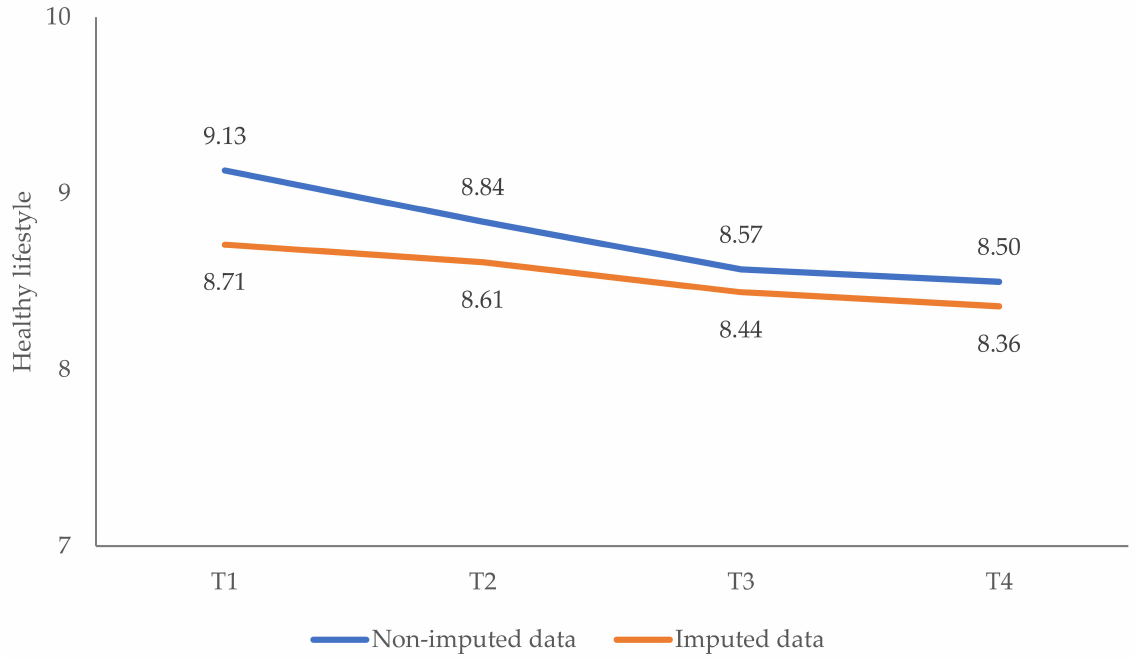
Figure A5. Changes over time in the subscale “Healthy lifestyle”: imputed vs. non-imputed results. Note: Imputed dataset: n = 1001. Non-imputed dataset: n =